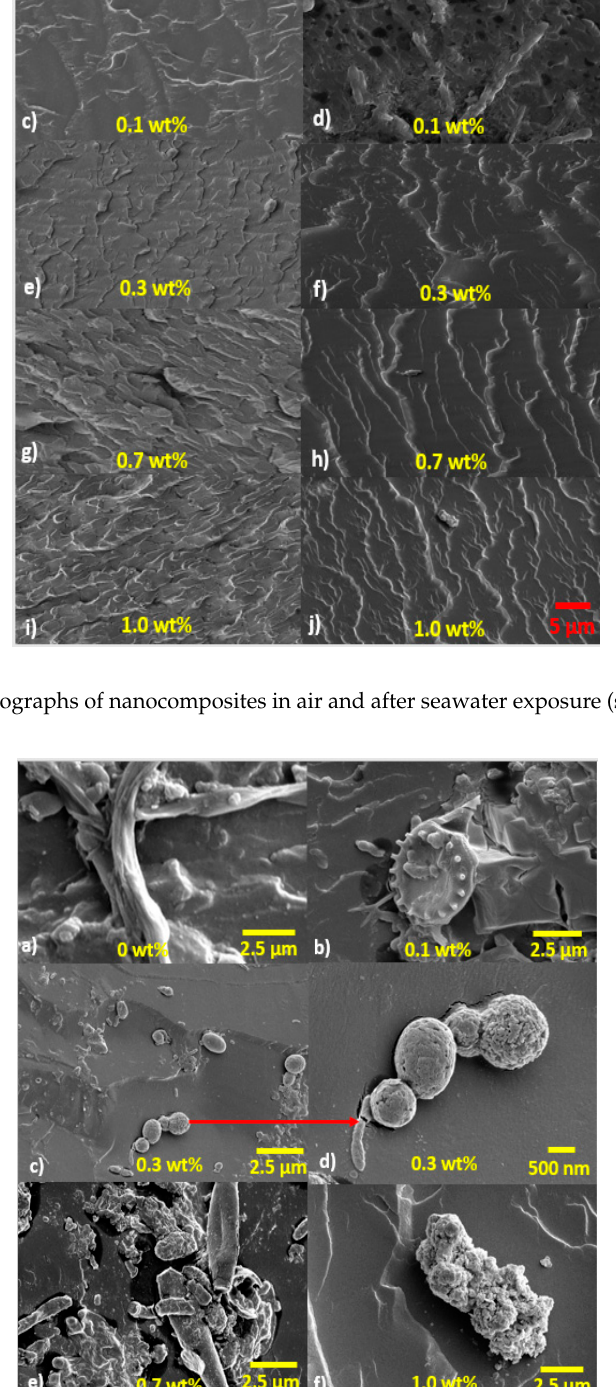
Figure 7. SEM micrographs of microbes on nanocomposites after seawater exposure.